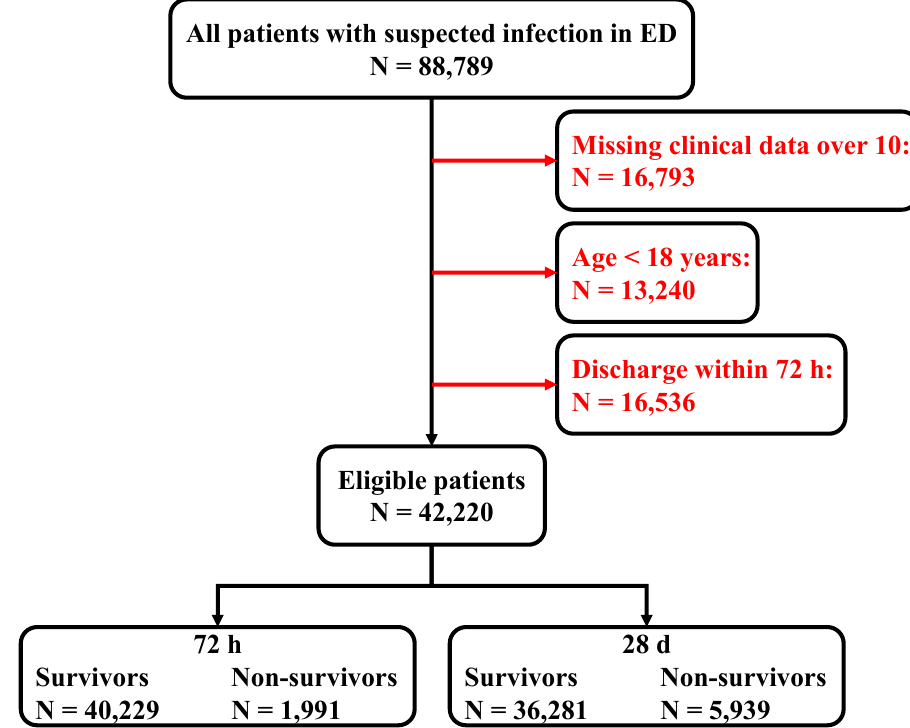
Figure 3. Structure of patient data management.